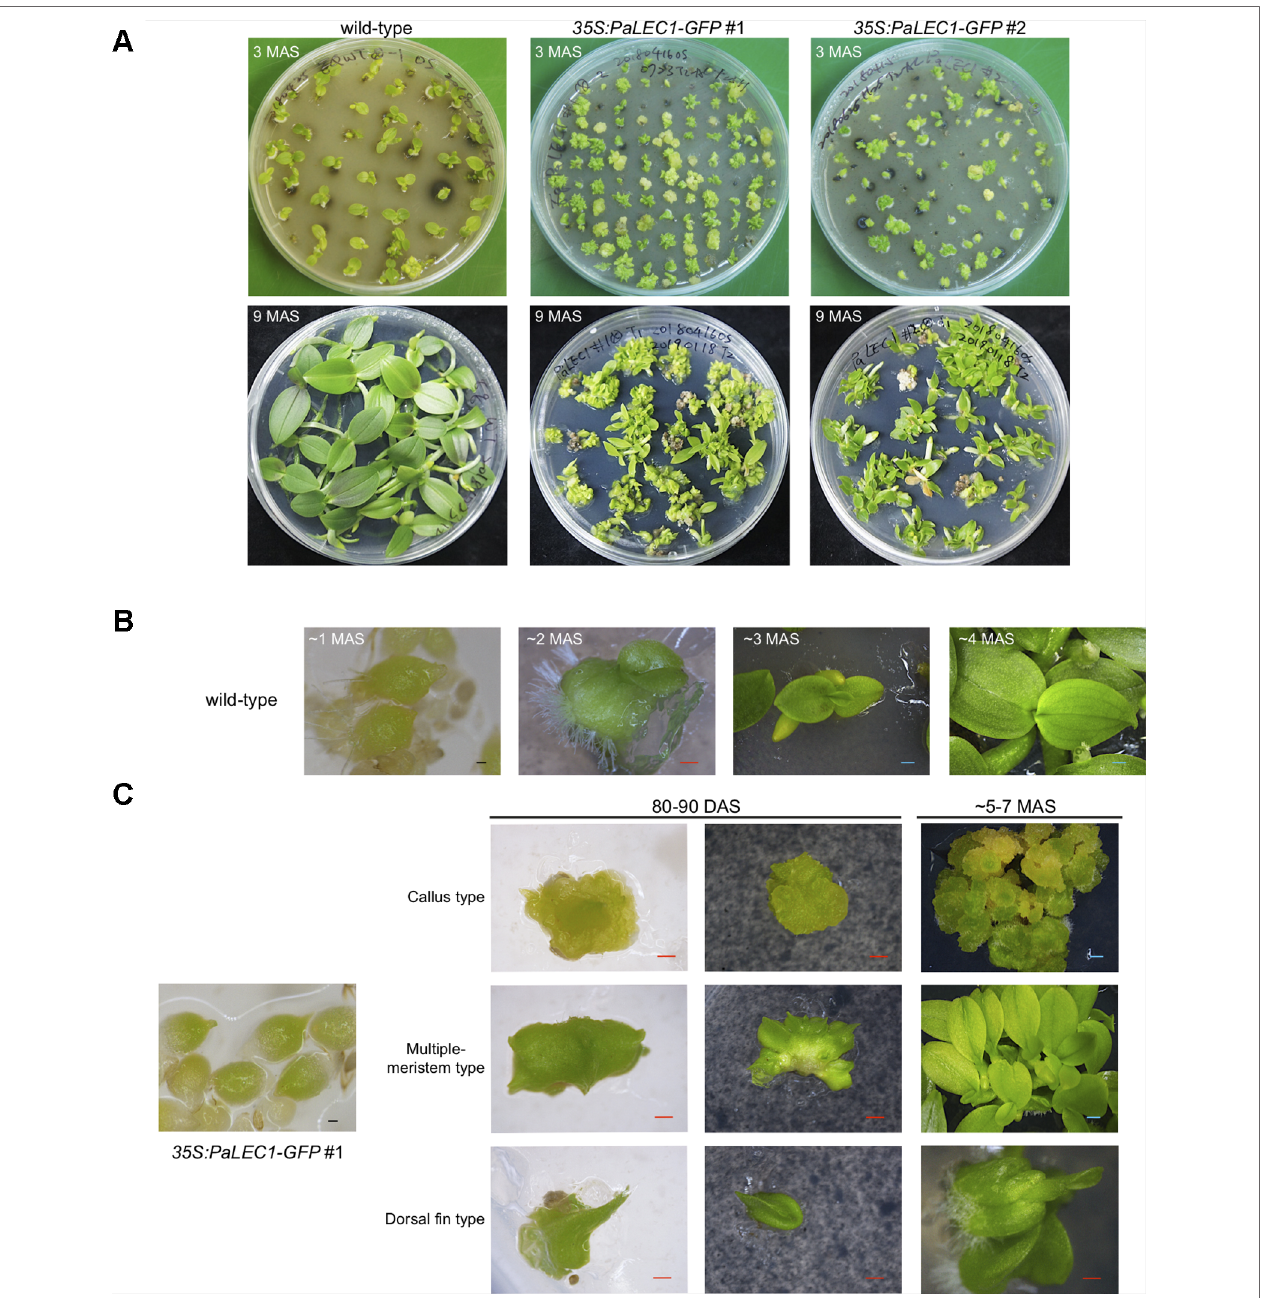
FIGURE 2 | Developmental processes of T1 35:PaLEC1-GFP #1 transgenic plants. (A) Developing seedlings of wild-type plant, 35:PaLEC1-GFP #1 , and 35: PaLEC1-GFP #2 transgenic plants at 3 and 9 months after germination. (B) Germinated protocorms of wild-type plants developed into young seedlings at 1, 2, 3, and 4 months after germination. (C) Germinated protocorms of 35:PaLEC1-GFP #1 transgenic plants developed into callus-type, multiple-meristem type, and dorsal fi n-like structures. MAS, month after sowing; DAS, day after sowing; Red scale bar = 500 m m. Blue scale bar = 1